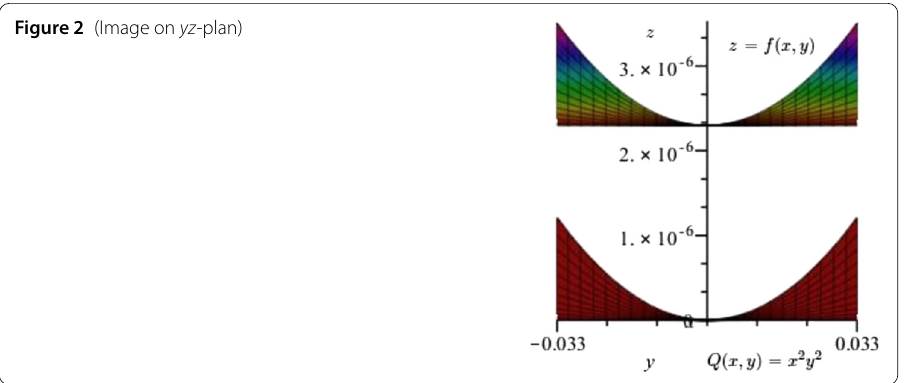
Figure 2 (Image on yz